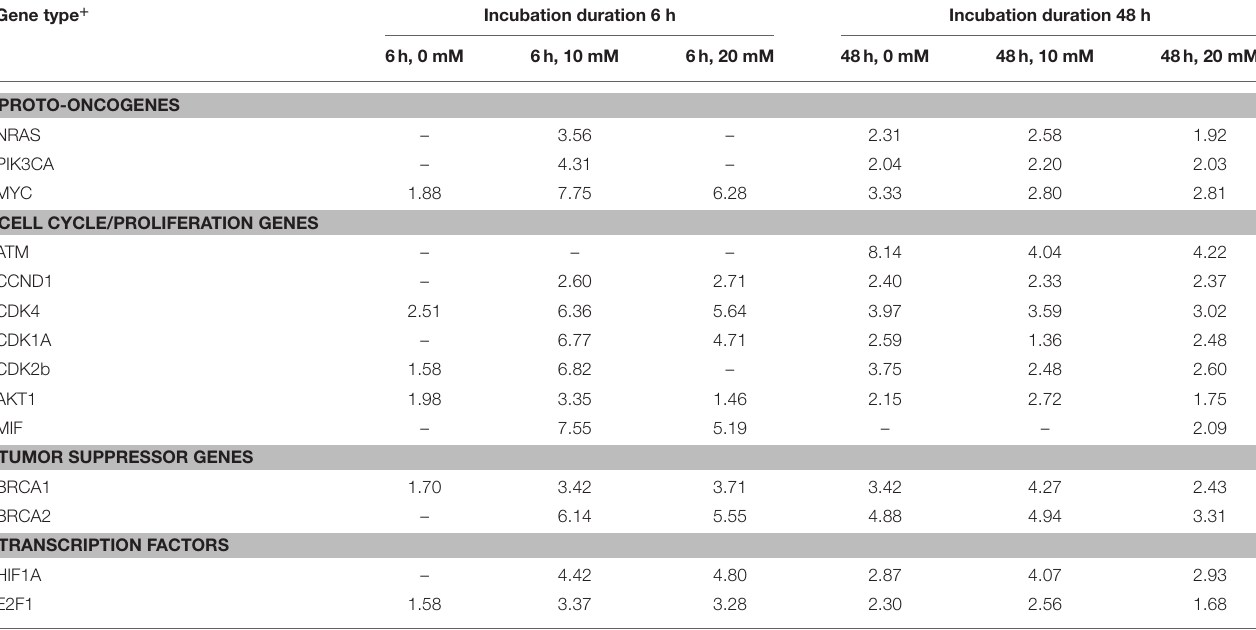
TABLE 1 | Fold changes in expression for cancer-related genes between glucose-starved MCF7 cells vs. MCF7 cells exposed to 0, 10, or 20mM lactate for 6 or 48 h. Gene type